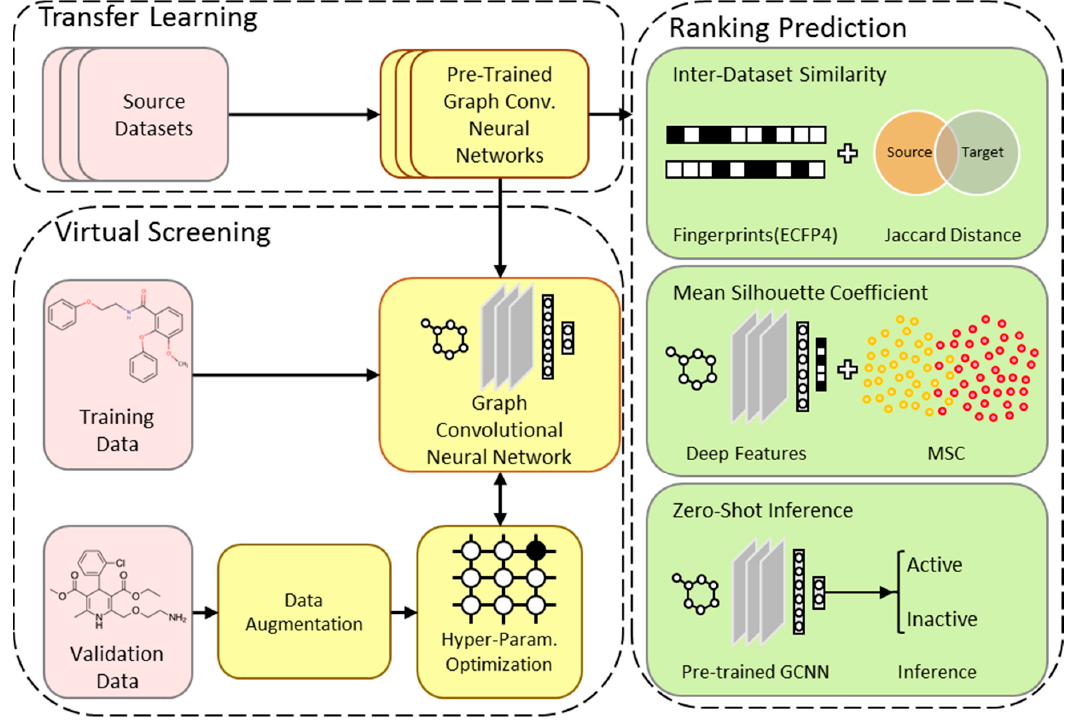
Figure 1. The overview of the TranScreen Pipeline. A common network architecture is determined and used to train multiple source models. The pre-trained models are fine-tuned on the target dataset. Three approaches are implemented to predict how well these pre-trained models can perform on the target task before fine-tuning.